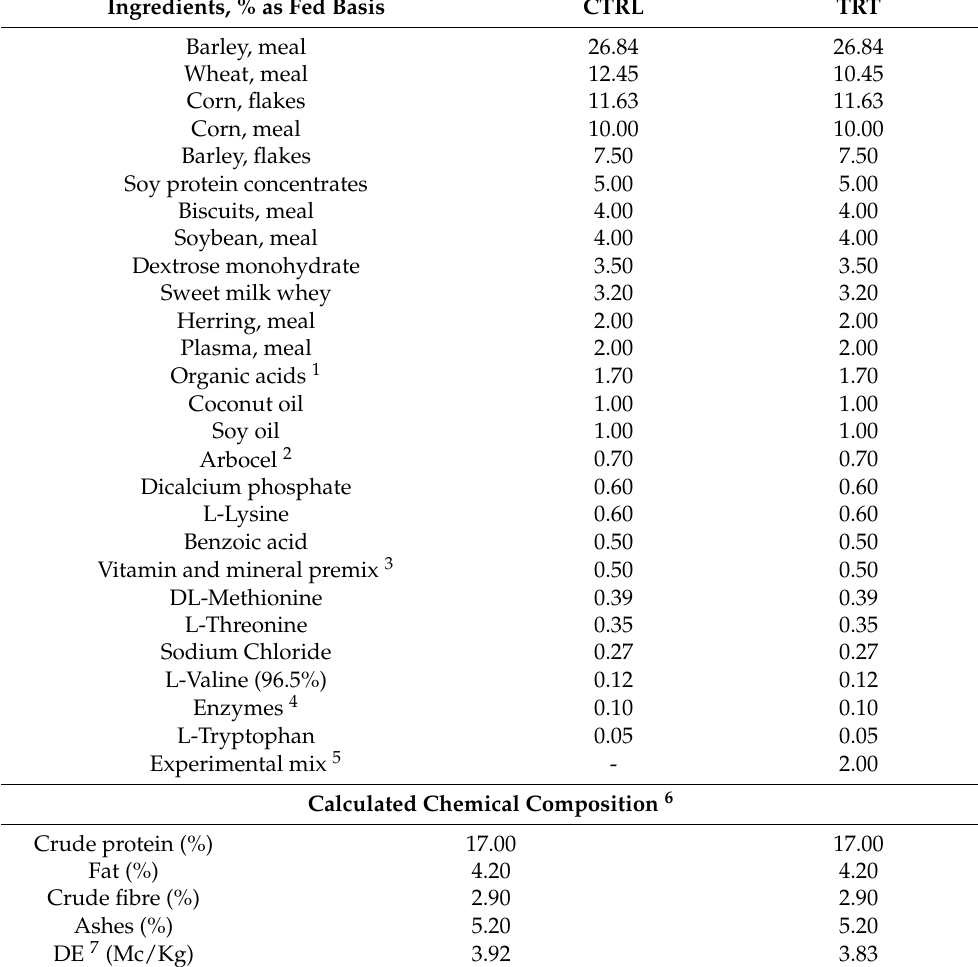
(wheat flour + bacterial strain in order to reach a concentration in the final preparation of 2 × 10 8 CFU/g). Table 1. Diet composition and principal chemical characteristics of experimental trial (% as fed basis) divided by control (CTRL, fed basal diet) and treatment groups (TRT, fed basal diet supple- mented with 2 × 10 8 CFU/g of Lactobacillus plantarum ; 2 × 10 8 CFU/g of Lactobacillus reuteri and 1 × 10 8 CFU/g of both bacterial strains; PLA, REU and P+R, respectively). Ingredients, % as Fed